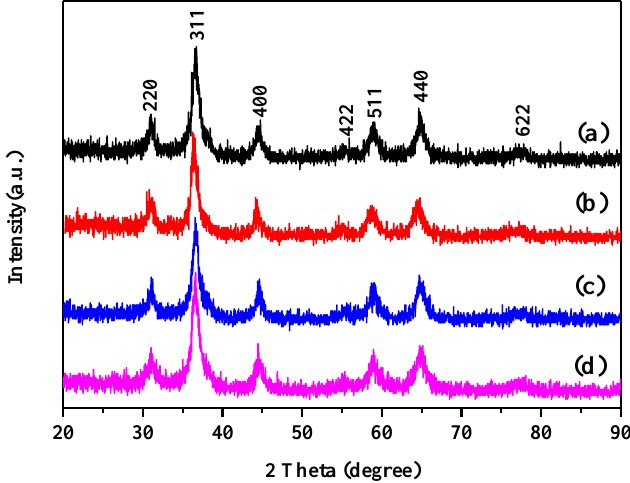
Figure 1. X-ray diffraction (XRD) patterns of the ( a ) MoO 3 -doped MnCo 2 O 4 (0), ( b ) MoO 3 -doped MnCo 2 O 4 (0.04), ( c ) MoO 3 -doped MnCo 2 O 4 (0.10), and ( d ) MoO 3 -doped MnCo 2 O 4 (0.12).